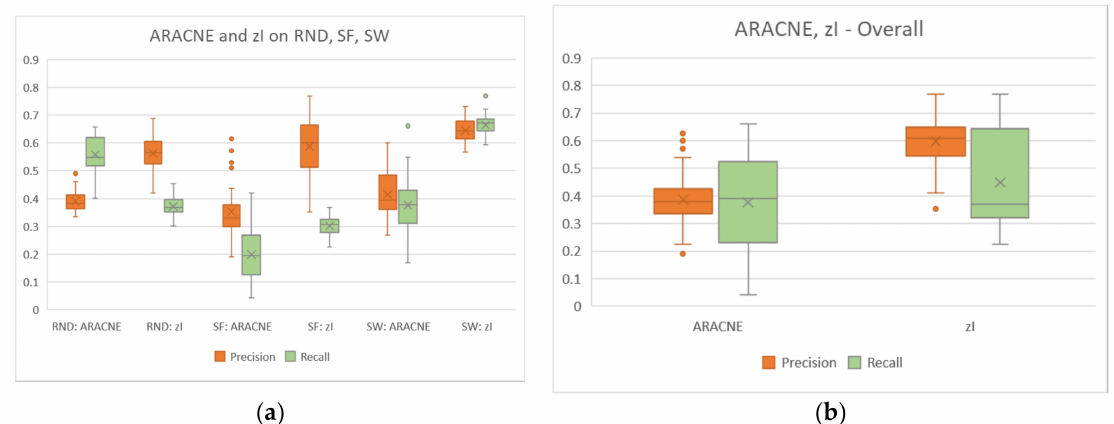
Figure 5. The reconstruction of the Century series. ( a ) Precision and recall relating to the reconstruction of each class of the genetic regulatory networks present in Century. ( b ) Precision and recall calculated on all systems together. The precision of the method is always significantly higher than that of ARACNE, with a very good recall—in SF and SW system the Recall is remarkably higher than that of ARACNE.